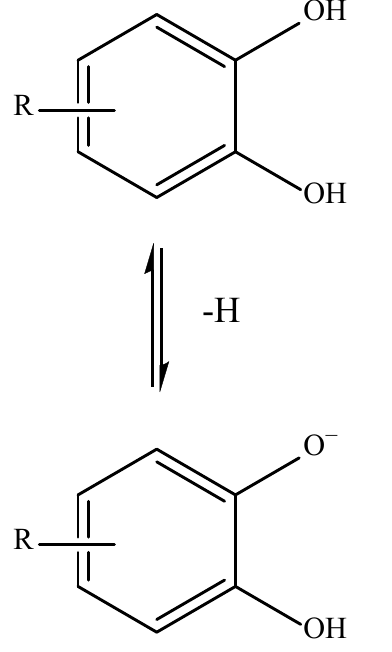
Figure 3. Phenolic acid derivative neutralizing a free radical via SET [46,53]. The third and fourth mechanisms by which the various phenolic acids exert their antioxidant capacity are known as transition metal chelation and sequential proton loss electron transfer (SPLET). The metal chelation mechanism is the ability of certain antioxi- dants to chelate transition metals, preventing them from catalyzing reactions that produce free radicals inside an organism (Figure 4). Some of these metals are Fe, Cu, and Mn [53,55]. On the other hand, SPLET, or sequential proton loss electron transfer, occurs when the antioxidant compound donates a proton to a free radical and transforms into an anion, which subsequently donates an electron to stabilize itself [53]. An example of this is shown in Figure